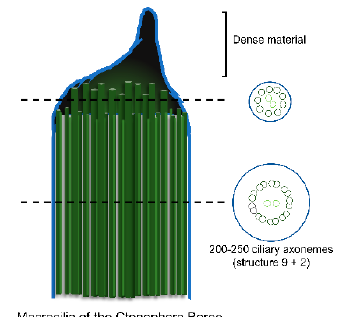
Figure 3. Diversity of cilia distal domain architectures. ( a ) Schematic representation of representative cilia tip structures. (I) In trachea cilia, the axoneme structure is (9+2) and at the tip the A-tubules and central pair are bound to a central cap that is attached to the ciliary crown, a structure constituted by a cluster of fibrils that project from the membrane to the outside of the cilia tip. (II) In the ciliate protozoa( Tetrahymena ) and green alga (Chlamydomonas ), the axoneme structure is (9+2). At the tip, the A-tubules are attached to the membrane by distal filaments that, in their proximal ends, form a plug which inserts into A-tubule lumen, while the central microtubule pair is bound to the central cap. (III). In the parasite protozoa Leishmania mexicana amastigote, the axoneme structure is (9+0). Distally, the 9-fold symmetry is broken by microtubule doublets progressively occupying a more central position. (IV) In the flat worm turbellarian the cilia present a typical (9+2) axonemal pattern through the main part of its length. Near the tip, this pattern changes to one where the microtubule central pair and doublets 1, 2, 3, 8 and 9 terminate in a distal cap that is attached to a ciliary crown, whereas doublets 4 to 7 end at a dense material of a proximal secondary cap. Therefore, the tip is asymmetric. (V) In the kidney primary cilia, the axoneme is (9+0) and progressively, along the axoneme, microtubule doublets suffer a displacement towards the center and the axoneme narrows towards the tip. In the distal segment, doublets are converted into singlets through the loss of the B-tubule. (VI). In the parasite protozoa Trypanosome brucei , the tip is (9+2) but the microtubule central pair is slightly shorter. Microtubule doublets and central pair present a dense material at the ends. (VII) In the adult Caenorhabditis elegans sensory amphid channel cilia (yellow) the axoneme is (9+a few singlets), and the microtubules maintain a radial organization and in vertebrate photoreceptors (purple) the axoneme is (9+0). However, both tips present only microtubule singlets. The differences can be observed at the cross section (VIII). In the adult Caenorhabditis elegans ’ sensory amphid wing cilia C, the middle region of the axoneme contains both doublets and singlets that “splay apart” laterally and end together ~0.5 µ m below the distal membrane. The tip presents a membranous fan-like structure. ( b ) Macrocilia of the ctenophore Beroe . Macrocilia present hundreds of ciliary axonemes with a (9+2) structure surrounded by a common membrane, with a giant capping structure. At the tip, doublet microtubules end and only singlet microtubules remain, linked together by electron-dense material. Central microtubule pairs are often still recognizable at this level. Schemes were based on: